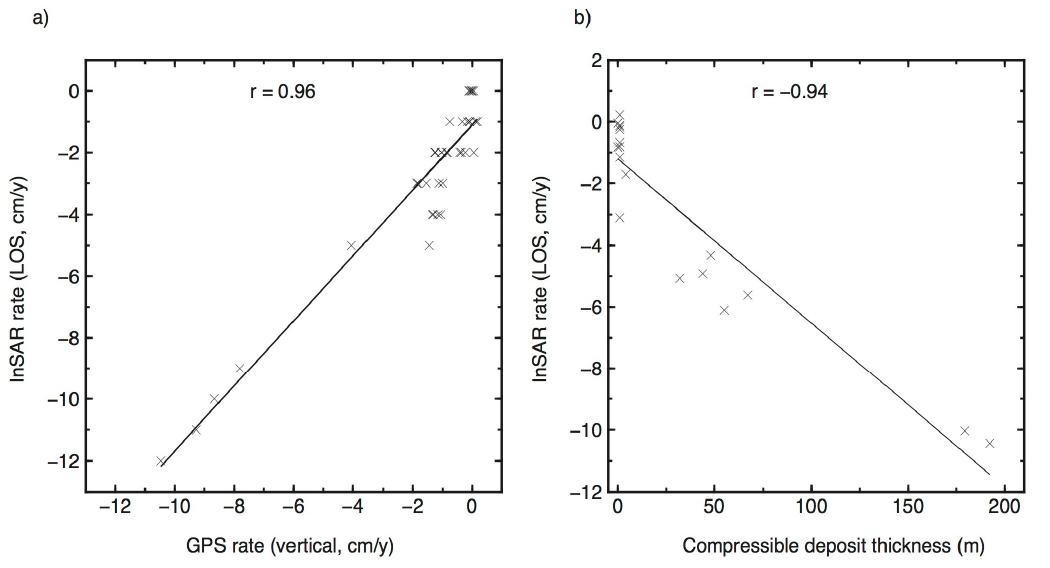
Figure 3. Correlation diagrams: ( a ) comparison between deformation rates estimated from InSAR and GPS data. Note that InSAR data cover the period 2003–2010, while GPS data cover three different periods (2004–2013, 2005–2013, 2009–2013) depending on the position of the GPS point (see Section 3.2 and Figure 1b). ( b ) Comparison between the InSAR-derived deformation rate and compressible deposit thickness.